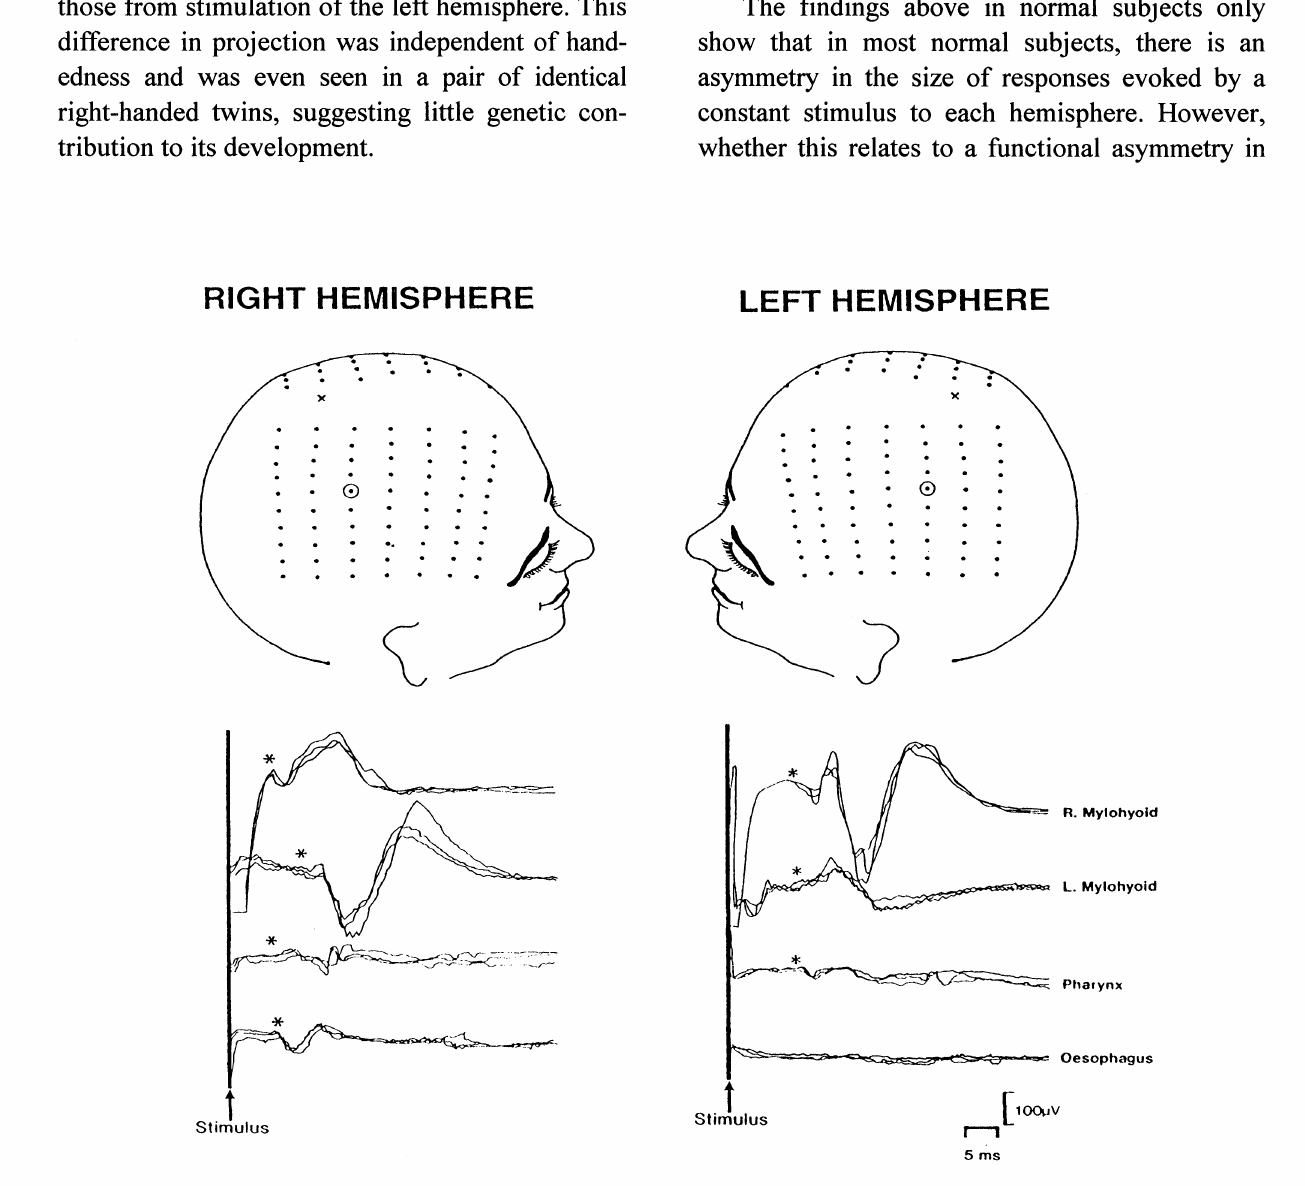
Fig. 1: EMG responses recorded from swallowing muscles following TMS of motor cortex. The upper panels show a grid of stimulation sites marked out on the scalp. In the lower panels are superimposed EMG responses after stimulation of the right and left hemispheres at the sites marked with (R). The vertex of the scalp is marked by a ’x’. An initial stimulus artifact can be seen in all traces, particularly in that from the mylohyoid muscles. This is followed after 8-10ms by a short latency response with an onset marked by * above each trace. Note that the responses evoked in pharynx and esophagus are larger following stimulation of the right than the left hemisphere. (From Hamdy et al.,